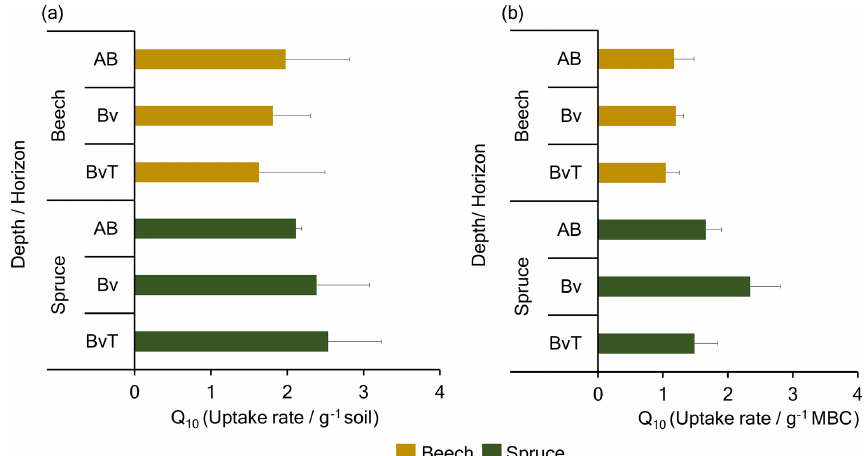
Figure 2. Temperature sensitivity ( Q 10 ) of dark CO 2 fixation rate measured from soil microcosms supplemented with 2% 13 CO 2 at 4 and 14 ◦ C. Shown are the Q 10 (temperature sensitivity) values of dark CO 2 fixation rates derived from fixation rates expressed in (a) µgCg − 1 ( dw ) soild − 1 (micrograms of carbon per gram dry weight (dw) of soil per day) and in (b) µgCg − 1 MBCd − 1 (micrograms of carbon per gram of microbial biomass carbon per day) after 21d of incubation with 2% 13 CO 2 across three horizons in the beech and spruce